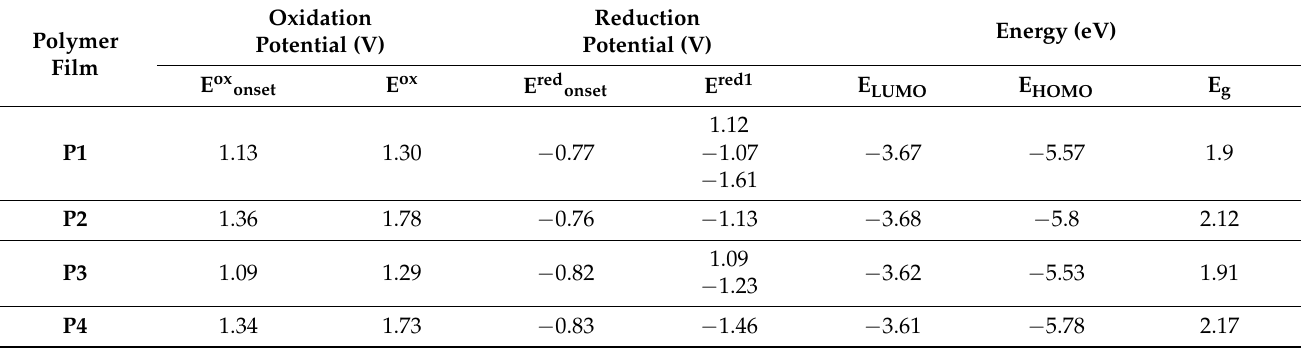
Figure 6. The CV curves of P1 − P4 films coated on ITO electrodes in ( a ) anodic and ( b ) cathodic regions. Table 3. The electrochemical characteristics of polyazomethines P1 − P4 films.